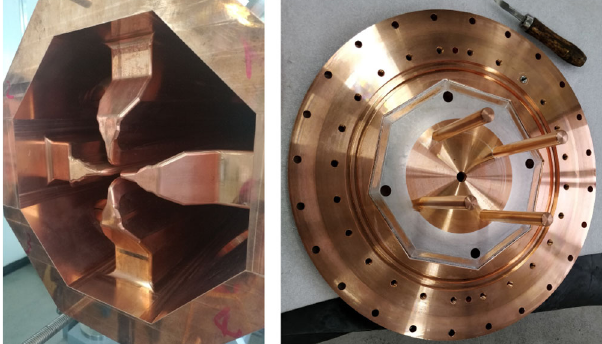
FIG. 6. Undercuts (left) and dipole-mode stabilizer rods (right) of the XiPAF RFQ.